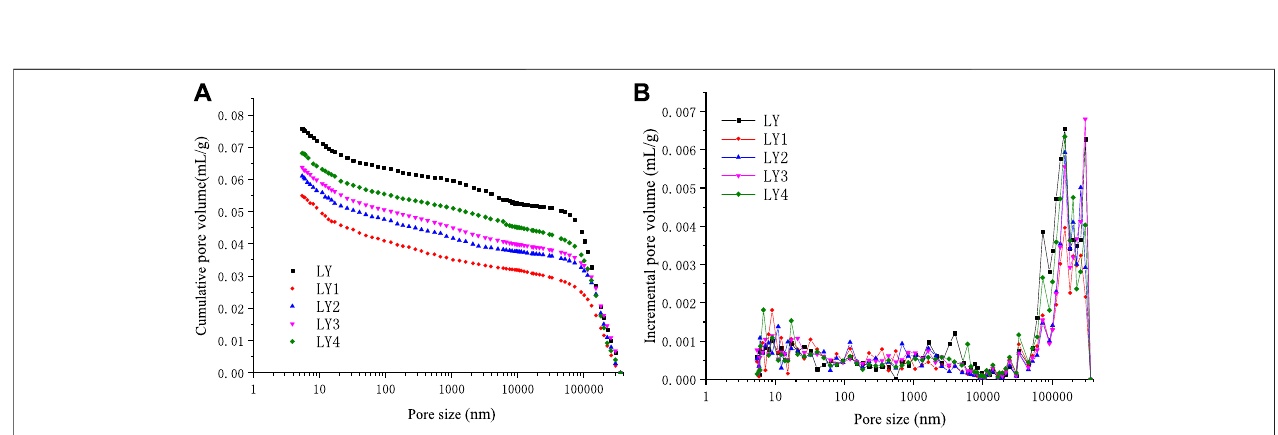
FIGURE7| PorevolumevsporesizeofLiulinminehardcoalafterhigh-temperatureandhigh-pressureadsorptiontest. (A) Cumulativeporevolumeofhardcoal (B) Incremental pore volume of hard coal.